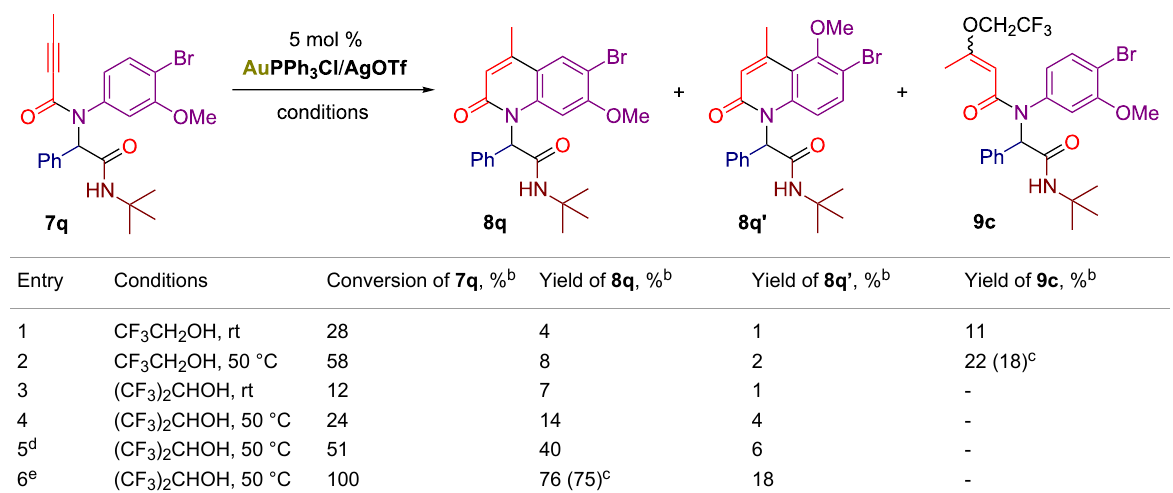
Table 4: Screening the conditions for the gold-catalyzed intramolecular hydroarylation of the Ugi adduct 7r . a